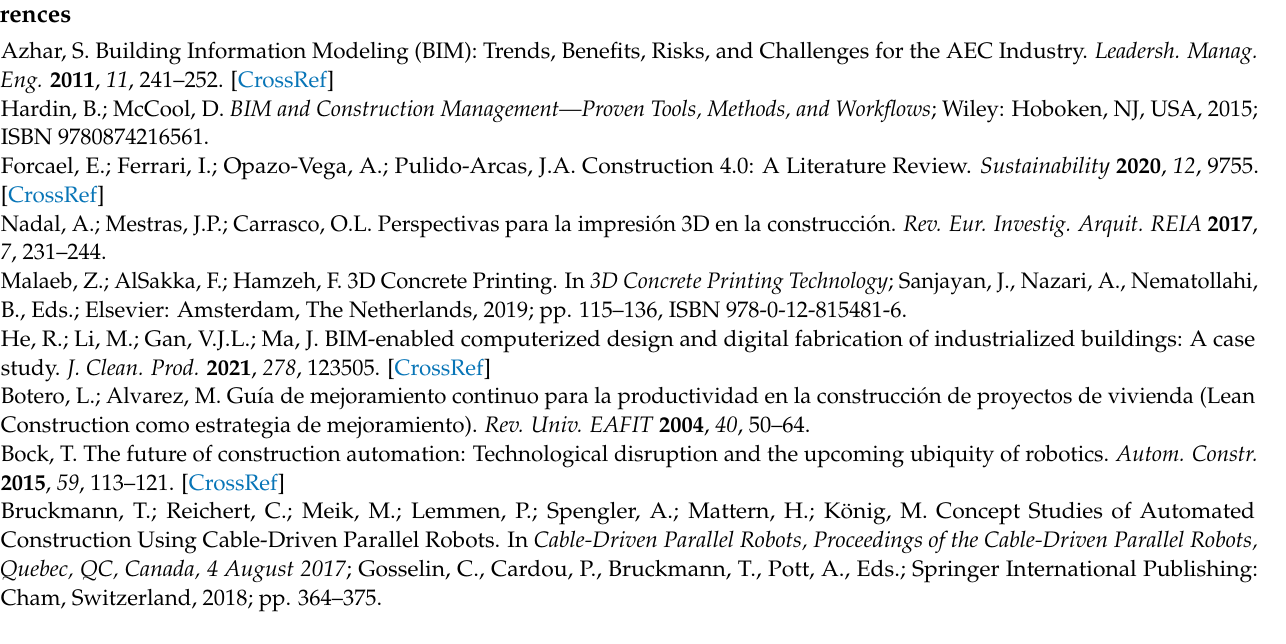
Figure A13. Exporting the calculation data to an Excel file. After selecting “Browse”, a tab will open in which the previously created Excel file has to be searched and selected. When this is done, the file will be automatically opened with all the data of measurements, total cost, and the cost of each material required for the printing. In addition, Dynamo TM allows importing the previously created Excel file into Revit TM , where all the data for printing the requested element can be